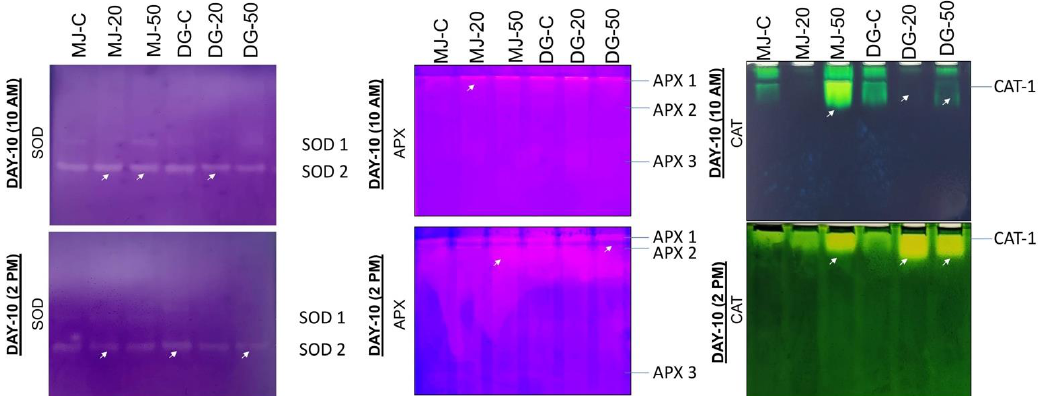
Figure 9. SOD, APX, and CAT isozyme activities in spinach genotypes Delhi green (DG) and Malav Jyoti (MJ). Results are presented for controls (MJ control; DG control), 20 mM of NaCl treatments (MJ-20 mM; DG-20 mM), and 50 mM of NaCl treatments (MJ-50 mM; DG-50 mM). Sampling was performed (on the basis of the circadian cycle) at 4 h intervals which corresponded to the exact times of 10 am, and 2 pm on day 10 of salinity stress. The white arrows indicate the changes in expression of bands among all treatments compared with controls.